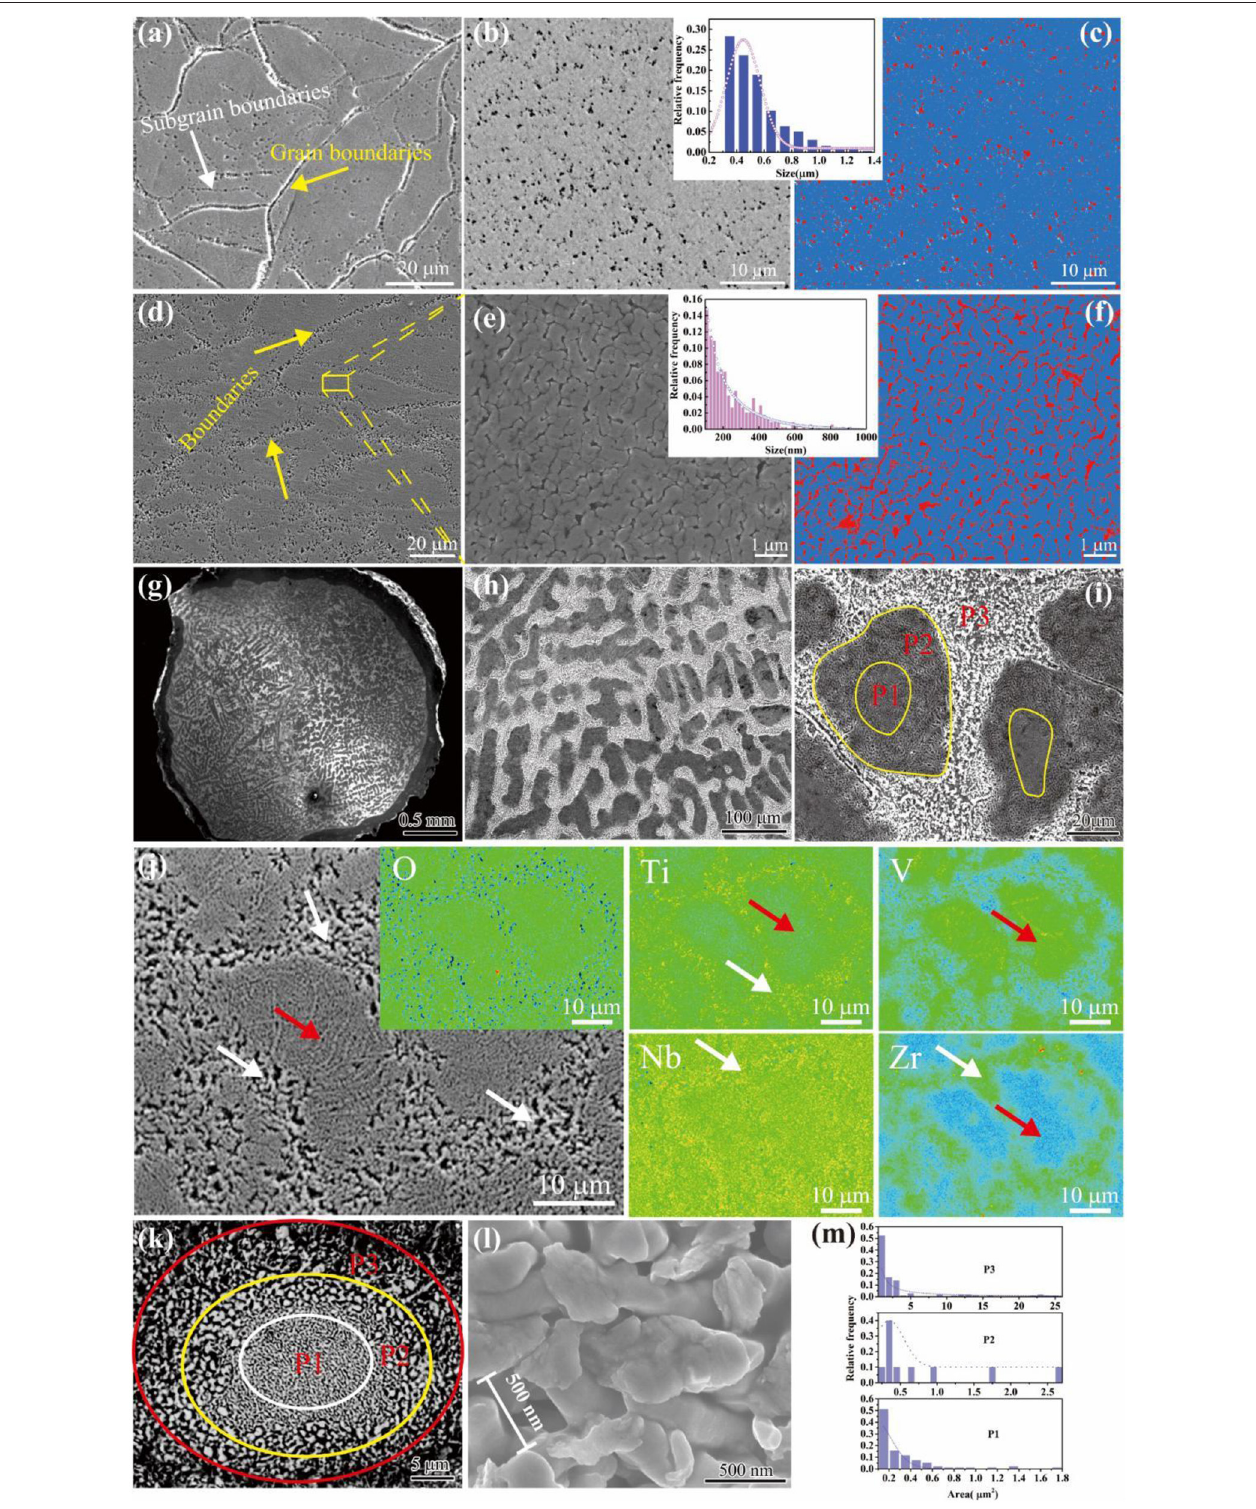
FIGURE 7 | Microstructural evolution of NbTiVZr alloy at elevated temperature. (a – c) SEM images showing the deformed microstructure at 600 ◦ C; (d – f) SEM images showing the deformed microstructure at 800 ◦ C. (g – k) SEM images showing the deformed microstructure at 1000 ◦ C; (m) the statistical results from (k) . O, Ti, V, Nb, and Zr are the EPMA mapping images corresponding to the SEM image (j) . (l) the enlarged image from P2.